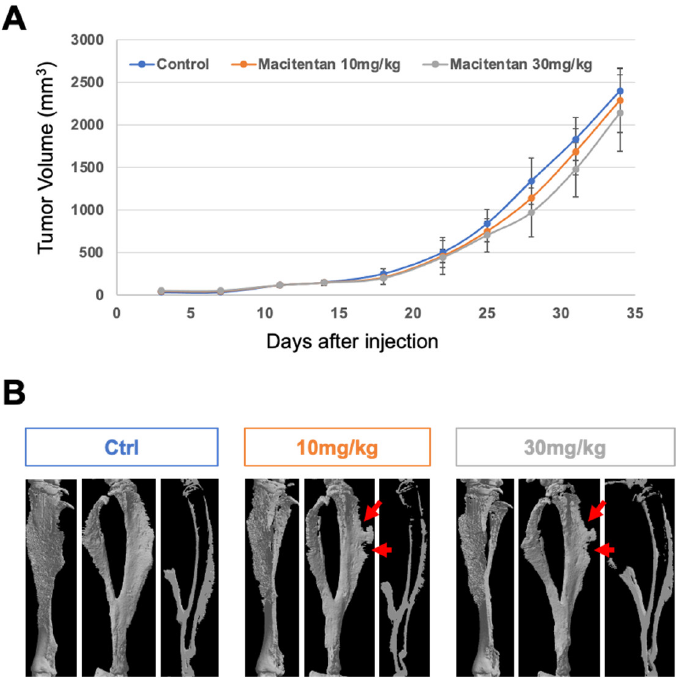
Figure 2. Impact of macitentan treatment alone at 10 and 30 mg/kg/day on MOS-J/PG1 tumor growth, associated bone resorption, and tumoral osteoid tissue formation. Whatever the dosage used, no significant impact of macitentan treatment was observed on tumor growth ( A ) but the final osteoid tissue volume appeared less significant (arrows in ( B )).